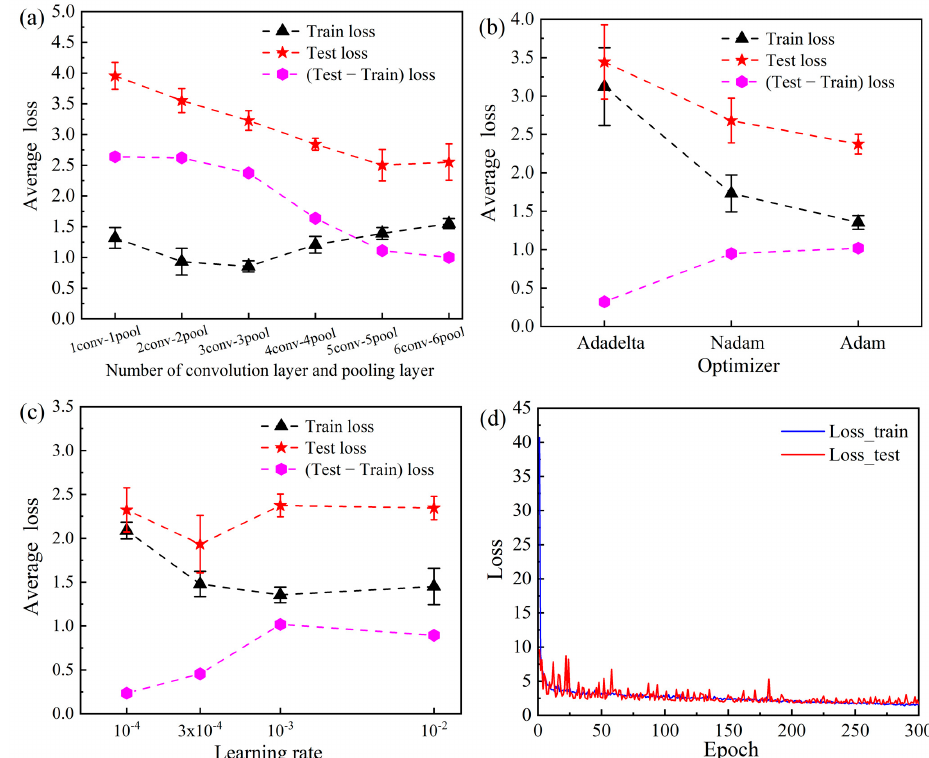
Figure 5. Performance optimization results: ( a ) number of convolution and pooling layers, ( b ) opti- mizer, ( c ) learning rate, and ( d ) epoch number.